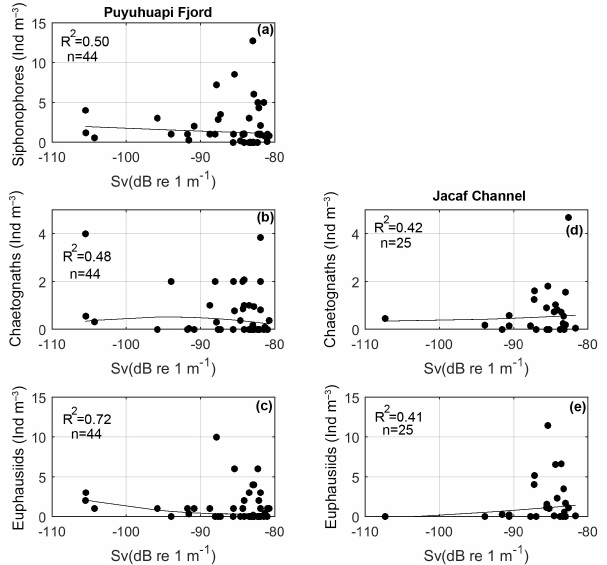
Figure 6. Scatter plot of volume backscattering strength ( S v ) from 38kHz frequency and the most abundant macrozooplankton species obtained in the in situ fixed stations carried out in Puyuhuapi Fjord (a, b, c) during 22–24 January 2014 and in Jacaf Channel (d, e) during 18–19 August 2014. Figure 7. Dual-frequency (38 and 120kHz) scientific echo-sounder transects along Puyuhuapi Fjord (0–18km) and Jacaf Channel (18– 35km) during nighttime on 17 August 2014. (a) Fluid-like and (b) blue noise echograms for zooplankton and (c) the fish echogram. Distribution indicated by colors representing S v values. The black arrow in (a) represents the entrance to Jacaf Channel. Horizontal red lines in (a, b, c) denote lower limits of usable acoustic data